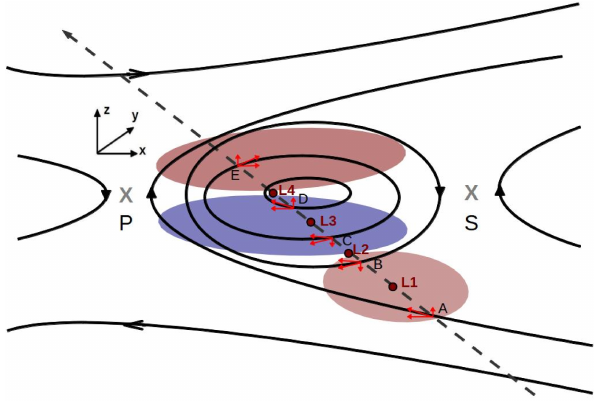
Figure 3. A schematic of reconnection at a primary ( P ) and a sec- ondary ( S ) sites. Components of the magnetic field in the x and z directions are shown by red arrows at select locations (A, B, C, D and E) on a spacecraft trajectory (black dashed line). The sign of the out-of-plane magnetic field B y in the regions of interest is represented by color-shaded (positive by reddish and negative by blueish) regions. The locations of zero crossings of the magnetic field components, marked by lines L 1 − L 4 in Figs. 2 and 4, are approximately indicated on the trajectory by filled